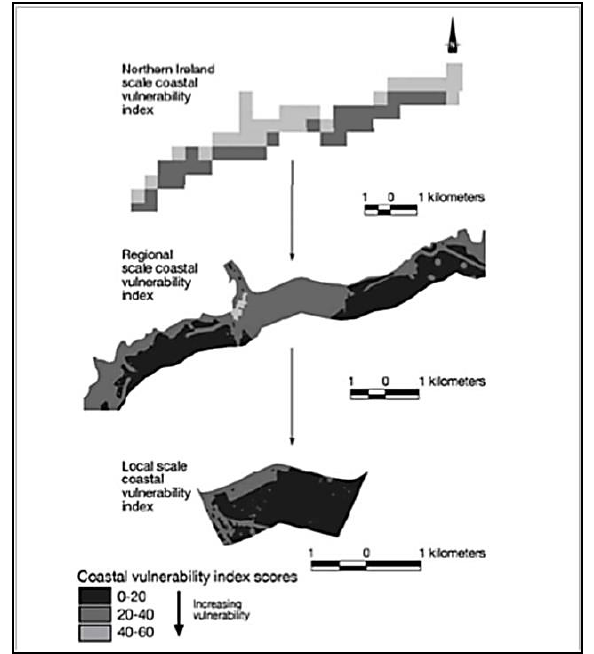
Figure 4. Map showing three spatial scales used in the study: Northern Ireland, Coleraine Borough Council and Portrush East Strand (McLaughlin and Cooper, 2010) Table 3. Physical parameter ratings associated with different levels of vulnerability (Palmer et al ., 2011; Kantamaneni et al. , 2018) Very low Low Moderate Physical variables Beach width Dune width >150 m Coastal slope Distance of vegetation behind the back beach >600 m Distance of built structures behind the back beach >600 m Rocky outcrop Sea defences Table 4. Coastal economic vulnerability parameters and threshold values (m, millions) (Balica et al. , 2012; Kantamaneni et al. , 2018) Very low Low Fiscal parameters